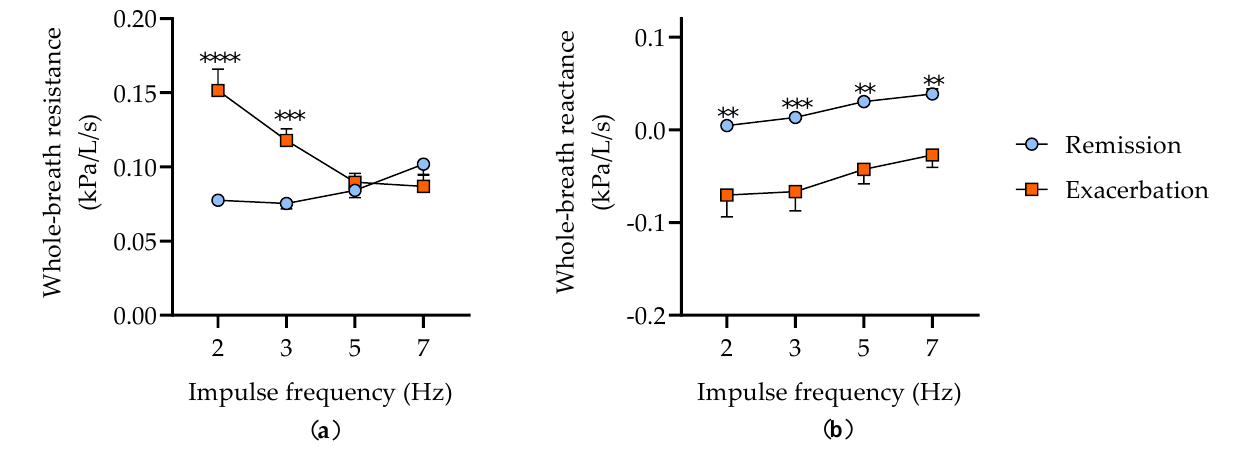
Figure 1. Lung function measured by oscillometry. Whole-breath resistance ( a ) and reactance ( b ) during remission and exacerbation of severe equine asthma (mean ± SEM). ** p < 0.01, *** p < 0.001, **** p < 0.0001 between remission and exacerbation with Bonferroni multiple comparison tests. The clinical status was also confirmed by the cytology of BAL fluid, as horses with severe asthma are expected to develop substantial airway neutrophilia during exacerba- tion. The natural antigenic exposure with hay increased the airway neutrophilia in all horses ( p = 0.008), with a concomitant decrease in the percentages of lymphocytes ( p = 0.014) and macrophages ( p = 0.003; Figure 2). The percentages of mast cells and eosinophils were low and did not vary with the clinical status (data not shown; the complete datasets are provided in the UdeM Dataverse repository).